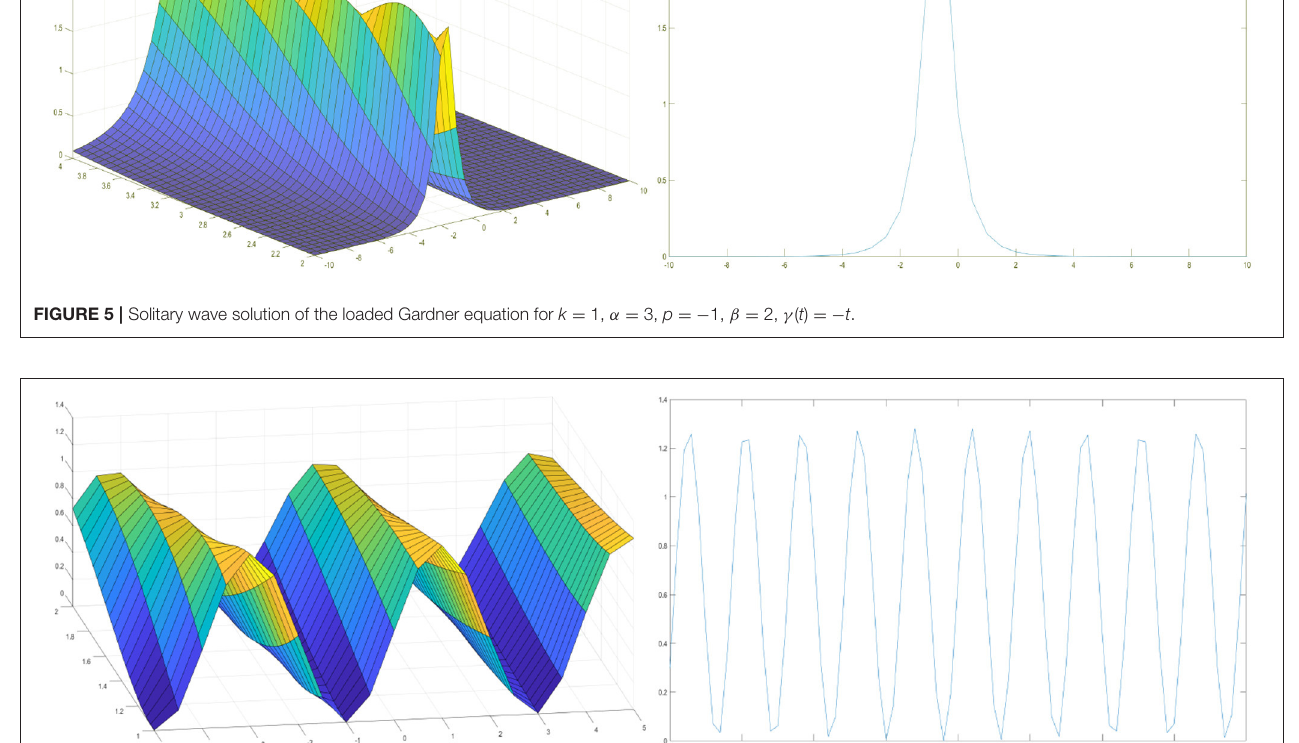
Frontiers in Applied Mathematics and Statistics |